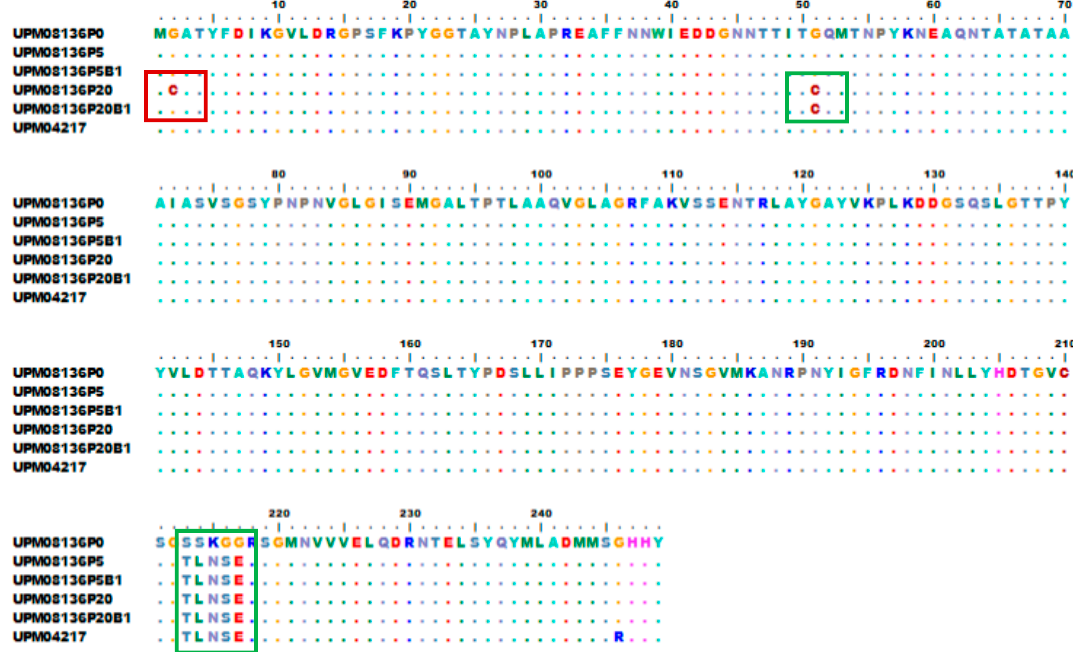
Figure 6. Multisequence alignment comparing the amino acid residues of hexon gene of the original, flask and bioreactor propagated isolates of UPM08136 and UPM04217 reference isolate from Genebank. There was a C to G substitution at position 2 (Red box) which is the only change observed between the bioreactor and flask isolates tested. Other changes (green box) remained the same between the flask and bioreactor isolates.